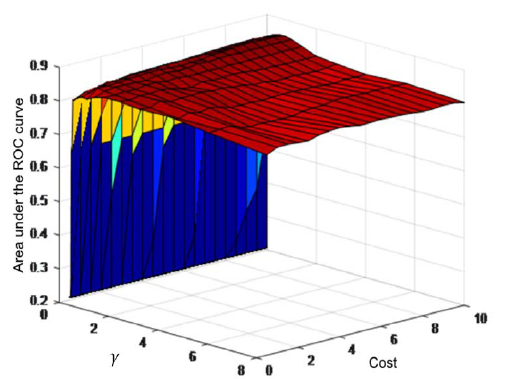
Figure 3. Example of the cross-validation process for a combination of 5 indices: meanNN l.m., SDCI, meanNN, meanCI and LF/HF. The area under the receiver operating characteristic (ROC) curve results are shown for the different values of cost and γ. The best area under the curve (AUC) value (0.8578) corresponds to a C value of 8.5 and a γ value of 0.7071.